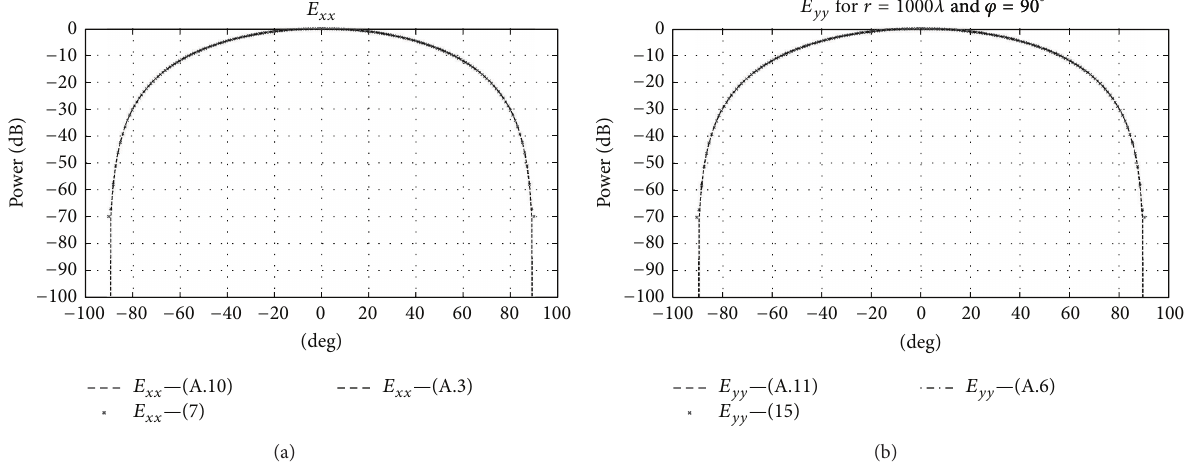
Figure 25: (a) Comparison of copolar ( 𝐸 𝑥𝑥 ) component of 𝑥 -directed electric point dipole in 𝜑 = 0 ∘ plane; 𝜆 = 3.2 cm. (b) Comparison of copolar ( 𝐸 𝑦𝑦 ) component of 𝑦 -directed electric point dipole in 𝜑 = 90 ∘ plane; 𝜆 = 3.2